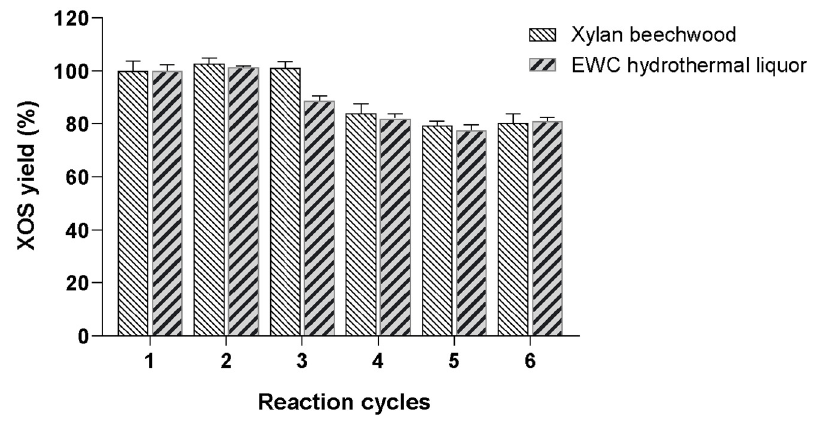
Figure 7. Operational stability of Purolite-MpXyn10 during successive reaction cycles for XOS production. Purolite-MpXyn10 derivative was used to catalyze six successive hydrolysis reactions of xylan beechwood and EWC hydrothermal liquor. The relative production of XOS was expressed as percentages of the products obtained in the first reaction cycle.